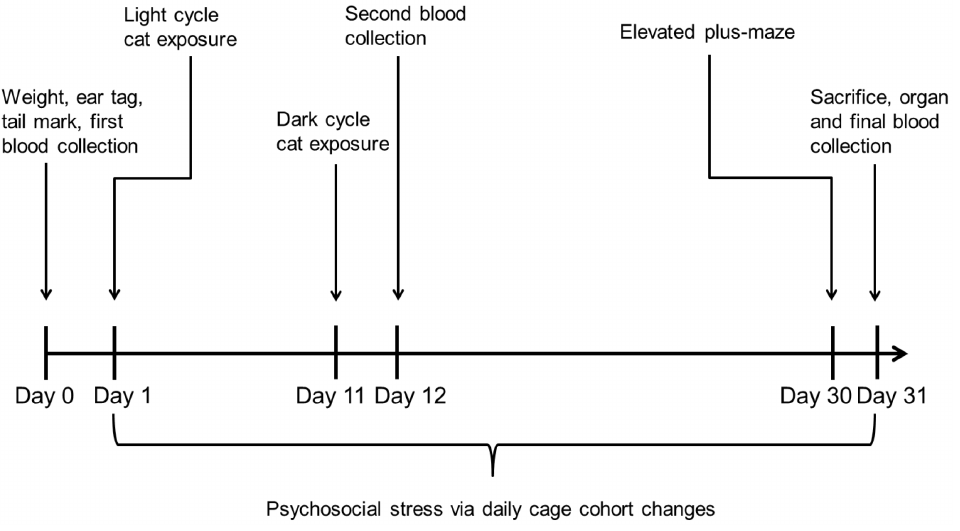
Figure 1. Predator exposure/psychosocial stress regimen. The predator exposure/psychosocial stress model includes two cat exposures over a 31-day period, combined with daily cage cohort changes. In addition, blood was collected at three different time points and ROS levels were measured to determine oxidative stress within groups and between groups. Anxiety was measured at the end of the stress regimen via EPM.